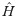
The two-dimensional simplex S in the space (x1, x2, x3).The points (x1, x2, x3) = (1, 0, 0), (x1, x2, x3) = (0, 1, 0), and (x1, x2, x3) = (0, 0, 1) correspond, respectively, to the vertices H^, P^, and N^, where all individuals play, respectively, strategies H, P, and N. Along the edge joining H^ and P^ (respectively, H^ and N^, P^ and N^) the strategy N (respectively, P, H) is not played.